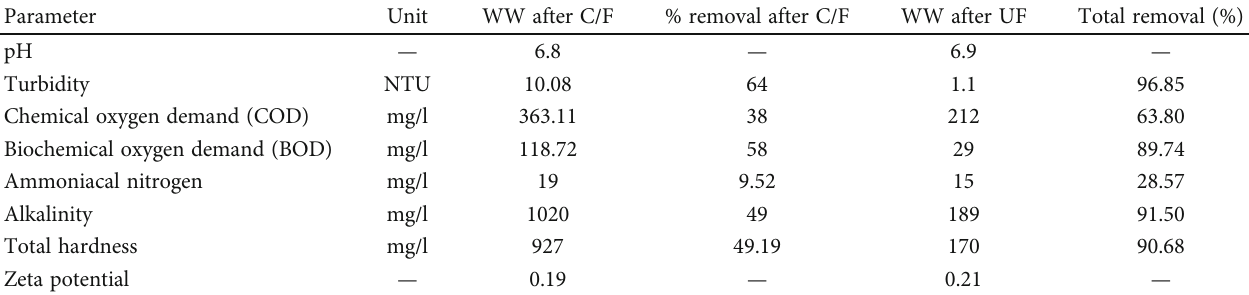
Table 3: Physicochemical characterization of FETP wastewater after the C/F using MO seeds and ultra fi